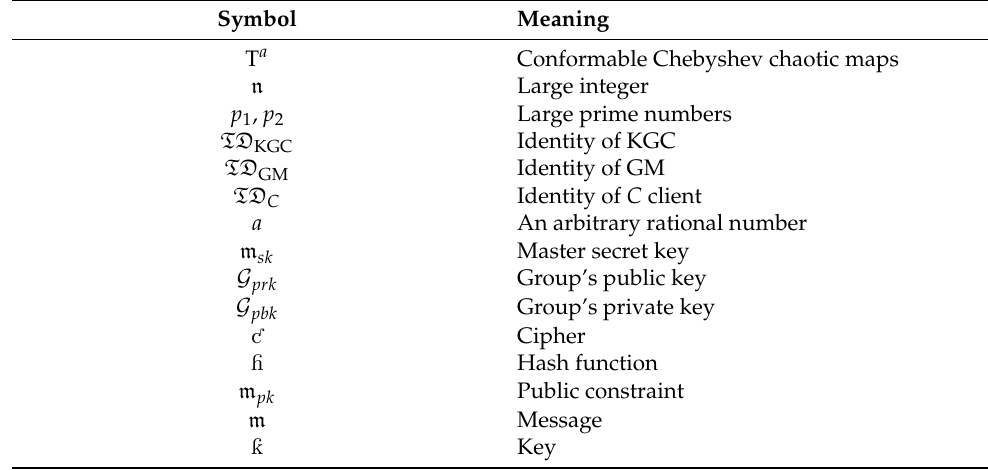
Table 1. List of